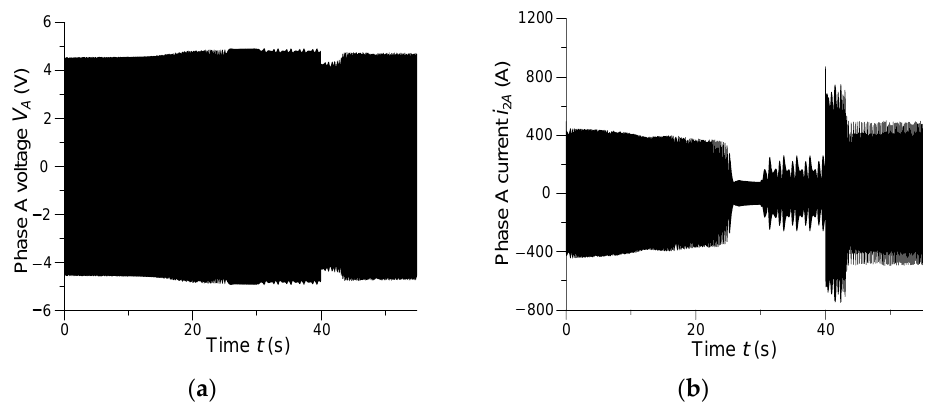
Figure 8. Instantaneous waveforms of: ( a ) phase A voltage of the drive system; and ( b ) phase A current of the power transformer secondary winding.